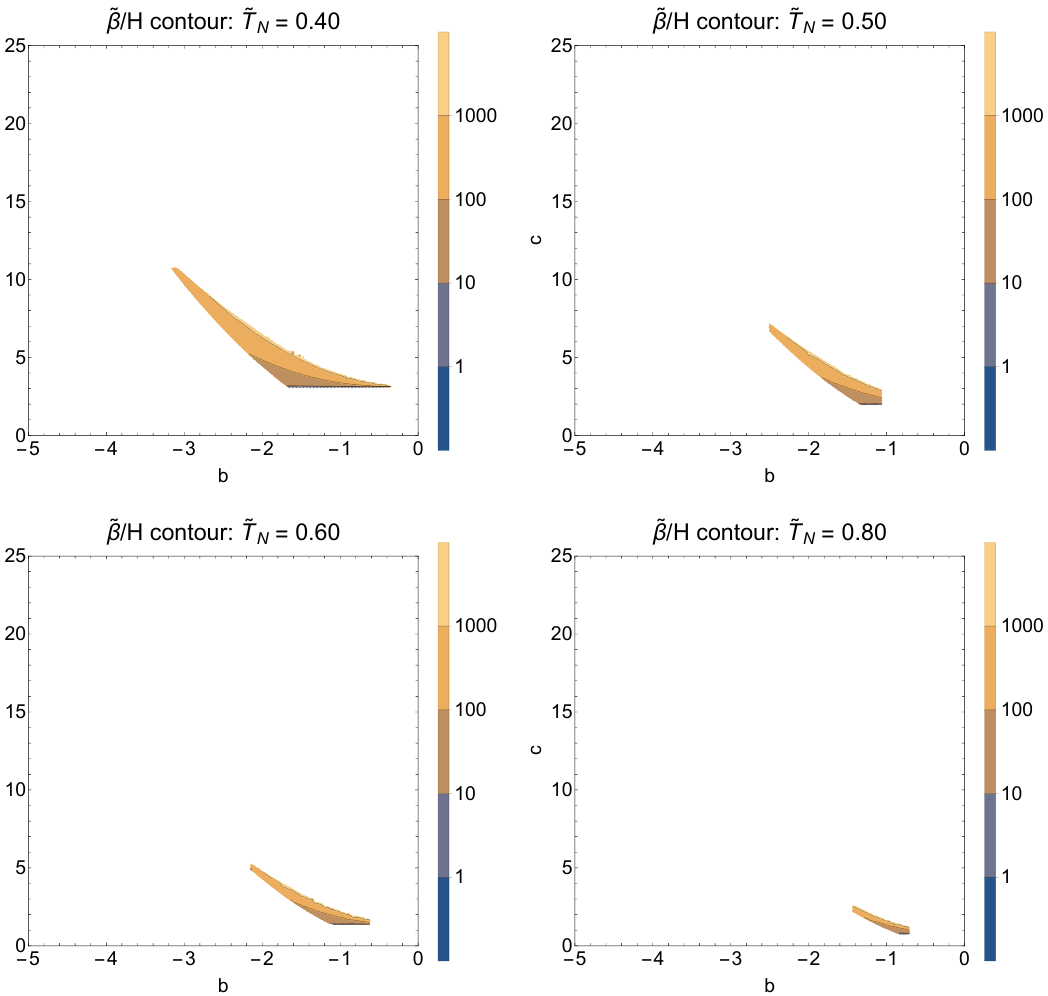
˜ Figure 4. Contours of β/H are shown in the ( b, c ) plane for the allowed parameter space for higher values of ˜ T : ˜ T = 0 . 40 (upper left), 0 . 50 (upper right), 0 . 60 (lower left), and 0 . 80 (lower N N right). The contours also satisfy the conditions: c ≥ b 2 , c ˜ T ˜ ˜ ˜ ˜ β/H ≥ S E / 140 T N and ξ ≥ 0